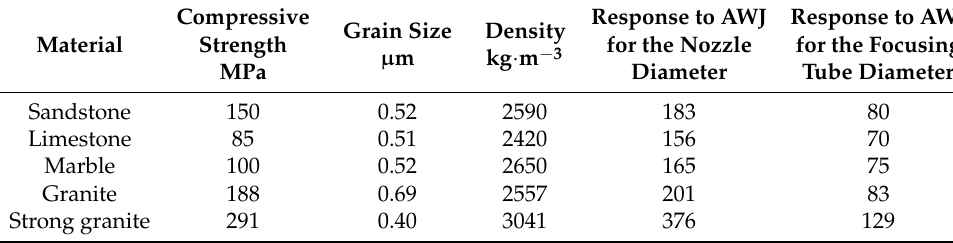
Table 3. Parameters of rocks; all samples were 30 mm